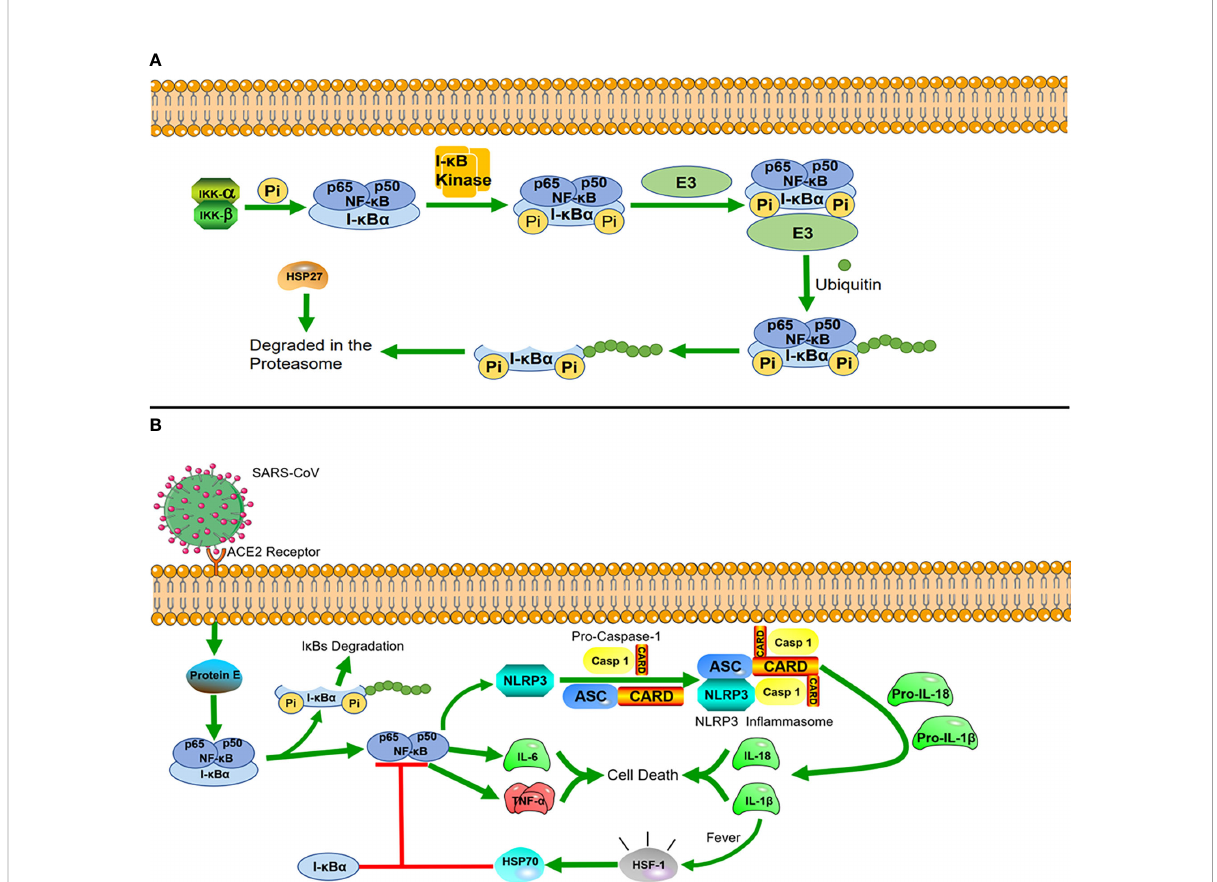
FIGURE 2 Heat shock proteins and immunological pathways (A) HSP27 regulates the NF- k B pathway. In the NF- k B signaling pathway, nuclear factor k B mainly exists as a heterodimer of p65 and P50, and I- k B a is a major inhibitor of NF- k B, which combines with them to form a complex in the resting state. The dimers are held inactive in the cytoplasm by their interaction with I-kB a proteins. I- k B a is phosphorylated when stimulated by external signals, and after phosphorylation, I- k B a proteins undergo ubiquitin-dependent degradation by the proteasome, after which NF- k B is translocated to the nucleus, where it acts as a transcription factor. The interaction of HSP27 with the 26S proteasome is necessary for the degradation of phosphorylated I- k B a , and overexpression of HSP27 enhances the proteasomal degradation of phosphorylated I- k B a . (B) HSP70 negatively regulates NLRP3 in fl ammatory vesicles. After SARS-CoV infects cells, the virus envelope E protein triggers the activation of the NF- k B in fl ammatory signaling cascade, which activates the NLRP3 in fl ammasome. Activation of NLRP3 induces the maturation of caspase-1, which in turn activates the secretion of interleukins IL-1 b and IL-18. While IL-1 b is an important factor in inducing a rise in core body temperature, HSP70, produced in response to the heat shock factor 1 (HSF-1), reduces the in fl ammatory response blocking NLRP3 and the articulator ASC to induce caspase-1 precursor maturation following a rise in body